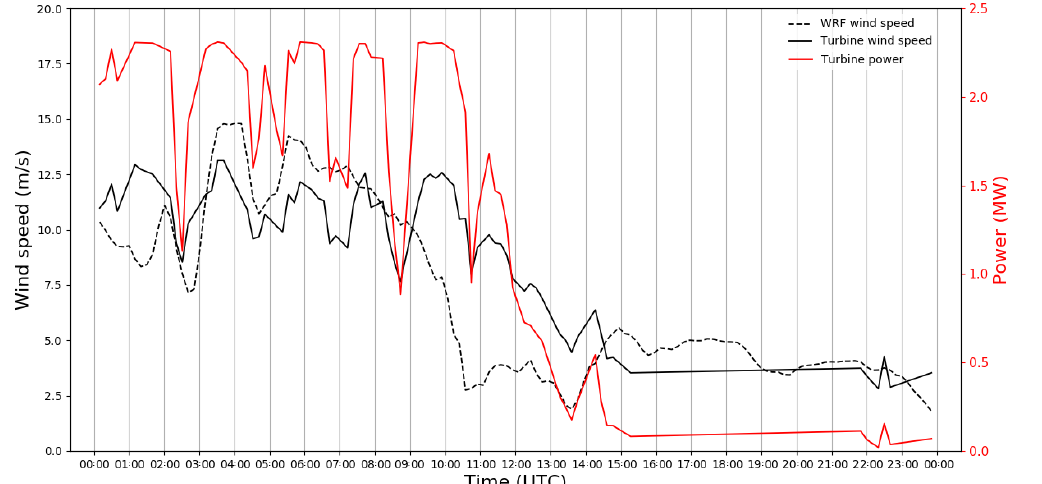
Figure 12. Time series of simulated 80m wind speed from WRF (dashed line), observed power output from one turbine near the middle of the wind farm (red), and wind speed measurements from that turbine (black solid line).